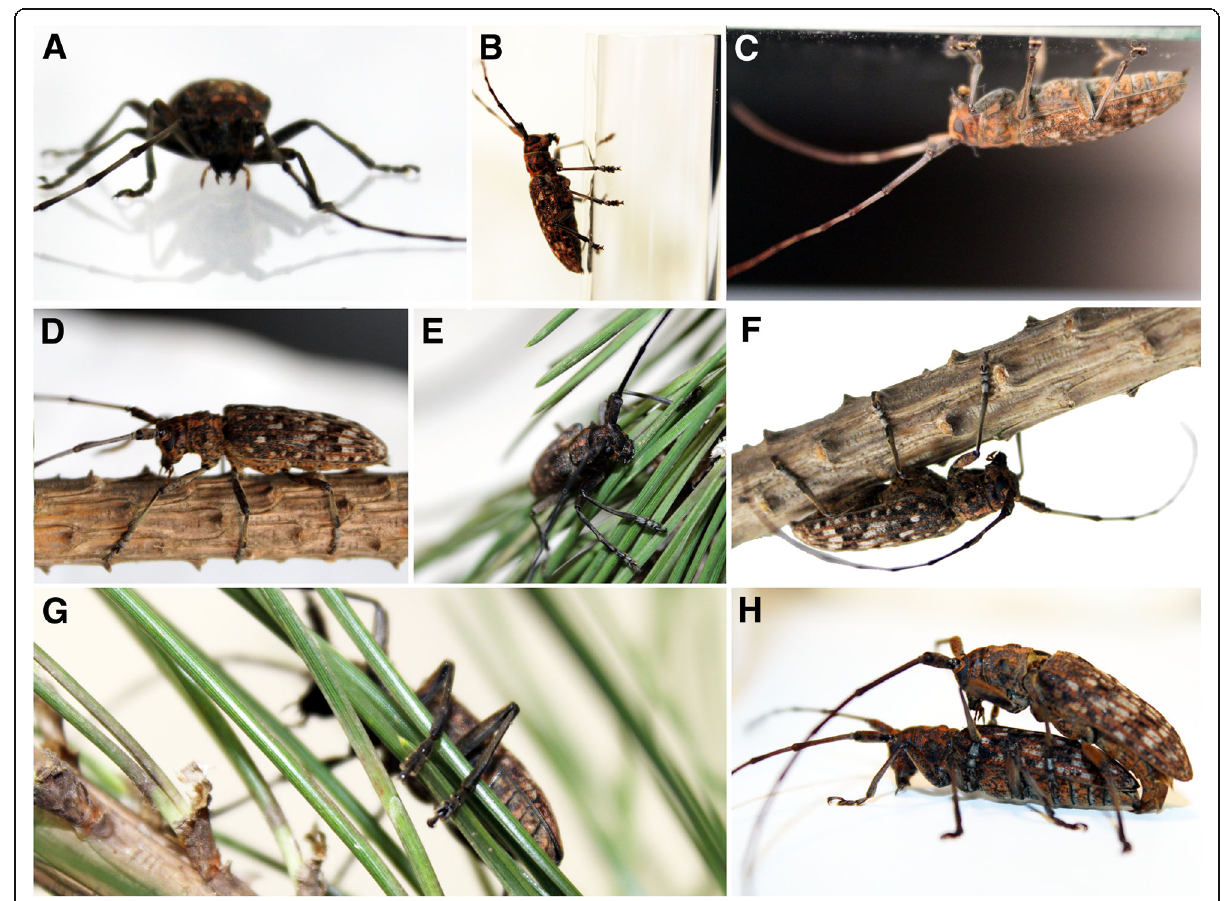
Fig. 1 Monochamus alternatus attached to different substrates at different positions: horizontal ( a , d , e ), vertical, upwards ( b ), and ceiling ( c , f ). a , c . Glass plate. b . Glass rod. d , f . Pine twigs (bark). e . Pine needles (leaves). g . A female clamps a bulk of several needles shaping some larger rod-shaped structure between their legs. h . A male grasping a female during copulation. Tarsi of fore- and middle legs adhere to the elytra, while the hind legs keep in contact with the substrate, but not with female ’ s